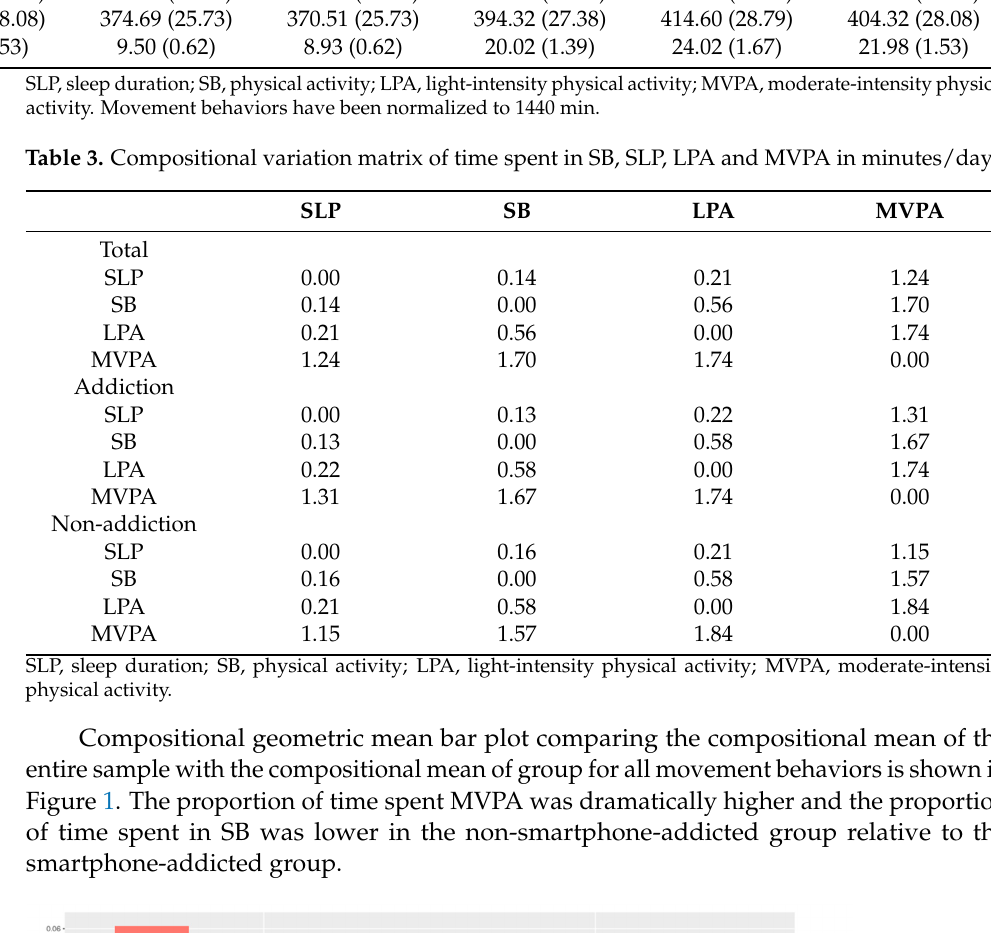
Figure 1. The proportion of time spent MVPA was dramatically higher and the proportion of time spent in SB was lower in the non-smartphone-addicted group relative to the